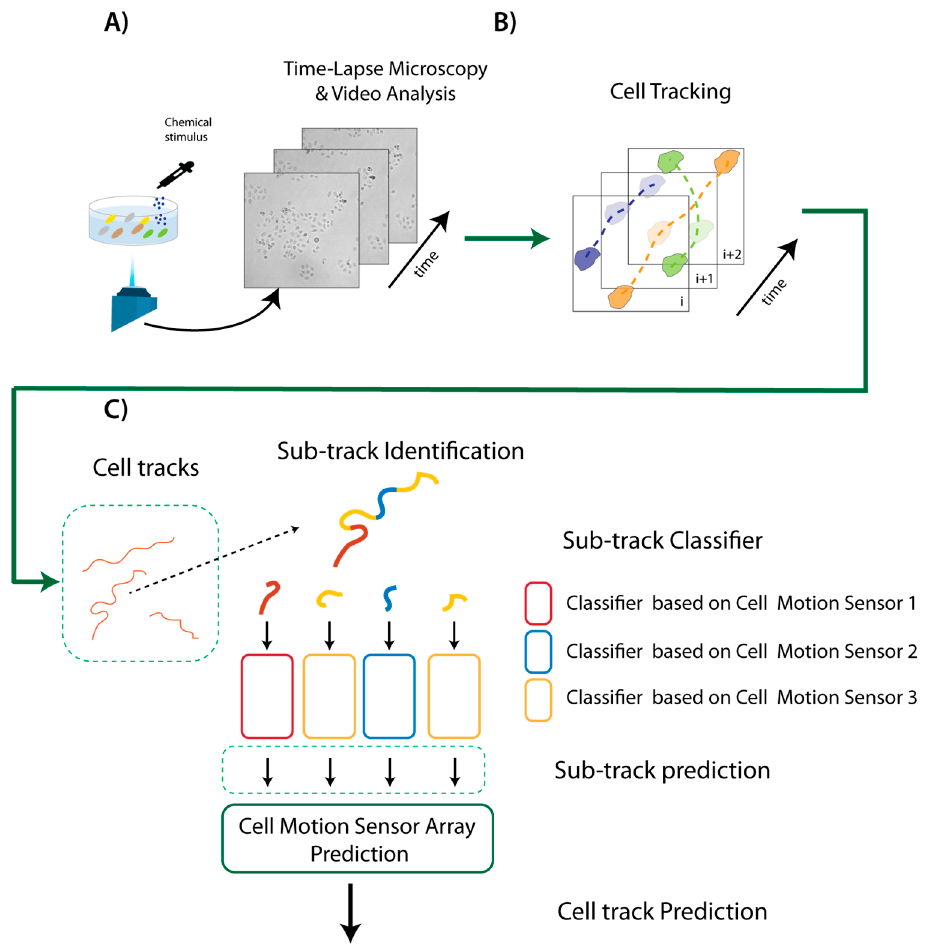
Figure 1. A Schematic representation of the whole sensor platform. A) The living cells sample